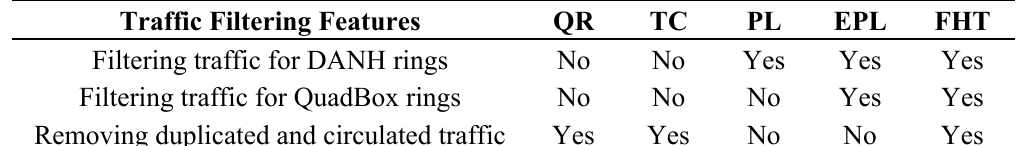
Table 1. Traffic filtering features of